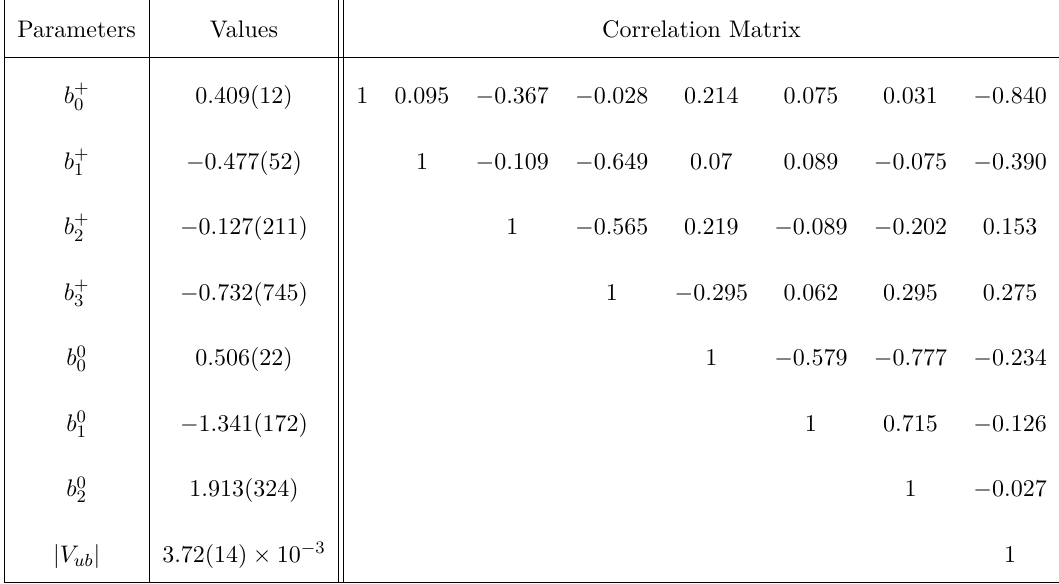
Table 6 . Theory predictions for the B → π‘ ¯ ν ‘ form-factor shape parameters and the CKM matrix element | V (with their correlation matrix) from carrying out the simultaneous fit against the ub | SCET sum rules, lattice QCD and experimental data points with the aid of the truncated BCL z -parameterizations at N = 4